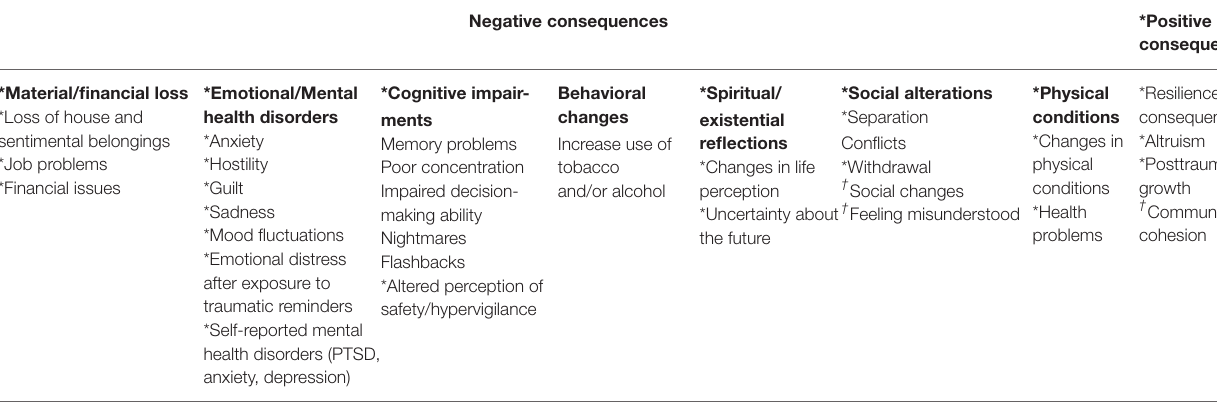
TABLE 3 | Biopsychosocial consequences of the